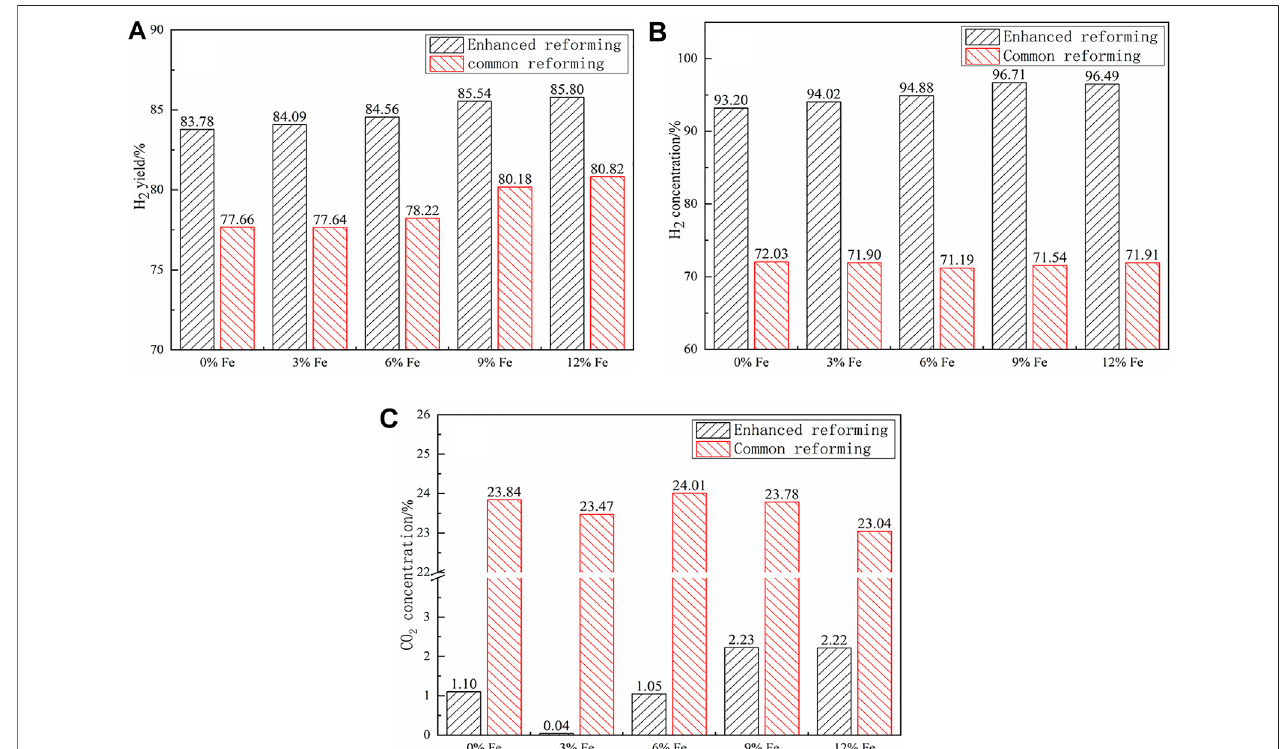
FIGURE 11 | Effect of the Fe-modi fi ed catalysts: (A) H 2 yield, (B) H 2 concentration, and (C) CO 2 concentration.